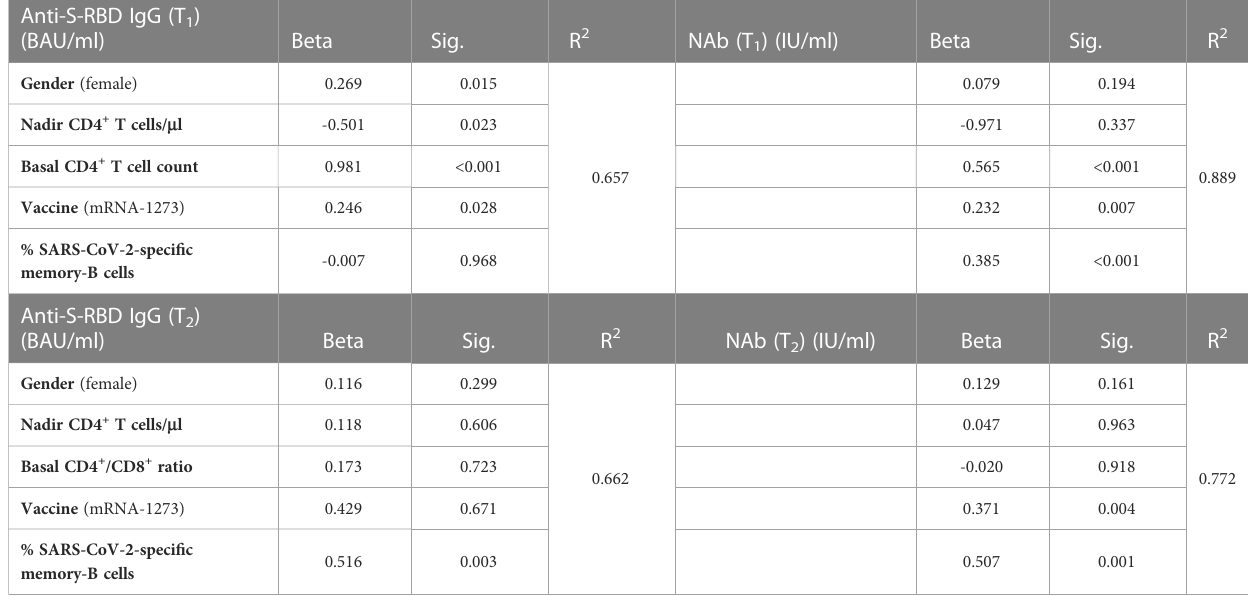
TABLE 2 In fl uence of different variables on the anti-S-RBD IgG and neutralizing antibodies (NAb) titers one month (T1) and 5.5 months (T2) after two doses of the BNT162b2 or mRNA-1273 vaccines. Anti-S-RBD IgG (T 1 ) (BAU/ml) Beta